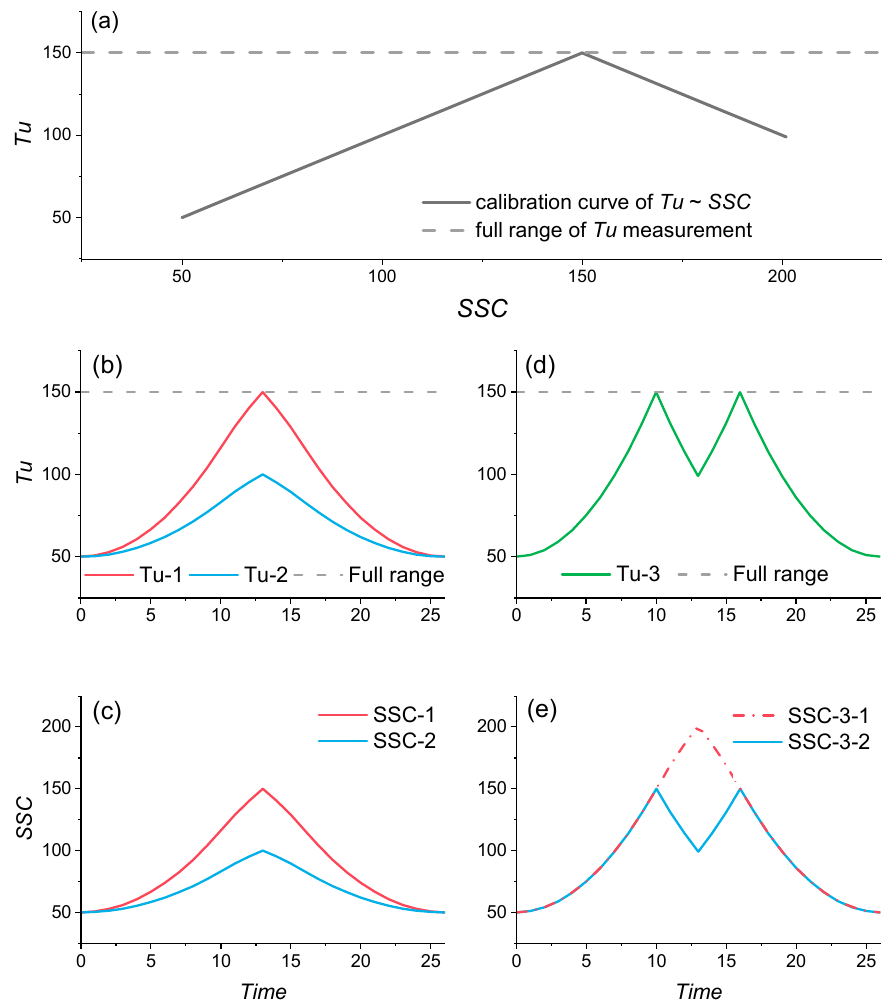
Figure 6. Diagram of Tu ~SSC conversions: ( a ) Schematized Tu ~SSC calibration curve and the full range of Tu measurement is marked; ( b ) Tu-1 and Tu-2: two types of temporal variations of Tu both having only one peak ( ≤ full range); ( c ) SSC-1 and SSC-2: temporal variations of SSC converted from Tu-1 and Tu-2 by the left (monotonic increasing) side of the calibration curve in subplot ( a ), respectively; ( d ) Tu-3: the third type temporal variations of Tu , showing two peaks at the full range of Tu measurement; ( e ) SSC-3-1 and SSC-3-2: possible SSC time series corresponding to Tu-3, in which SSC-3-1 indicates that SSC firstly increases and then decreases between the two peaks of Tu-3 while SSC-3-2 is the opposite. Note that the values in the coordinates only denote relative magnitudes.